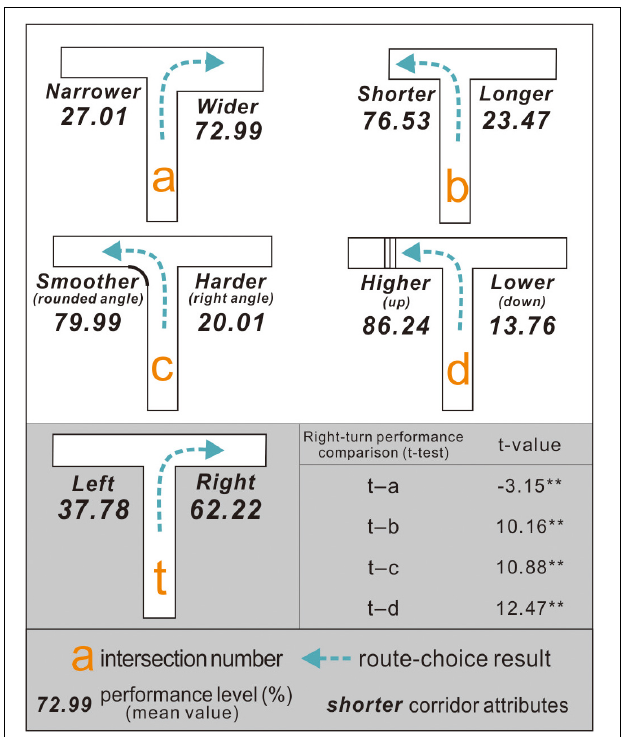
FIGURE 8 | Right-turn performance of exit-finders at intersections a – d indicated different preferences from intersection t .